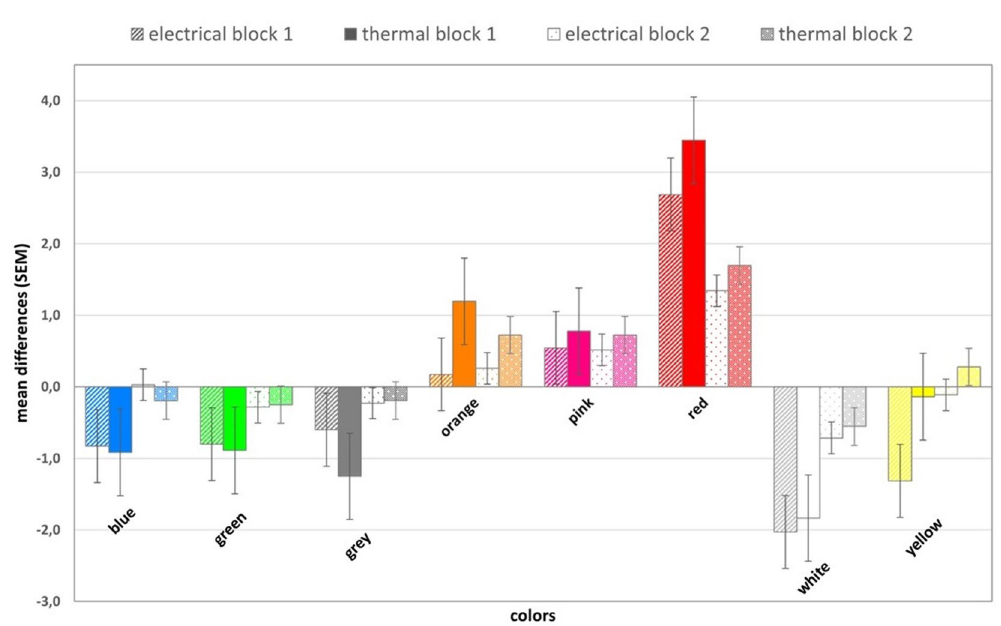
Figure 2. Means and standard errors of differences between expectation ratings between black and other